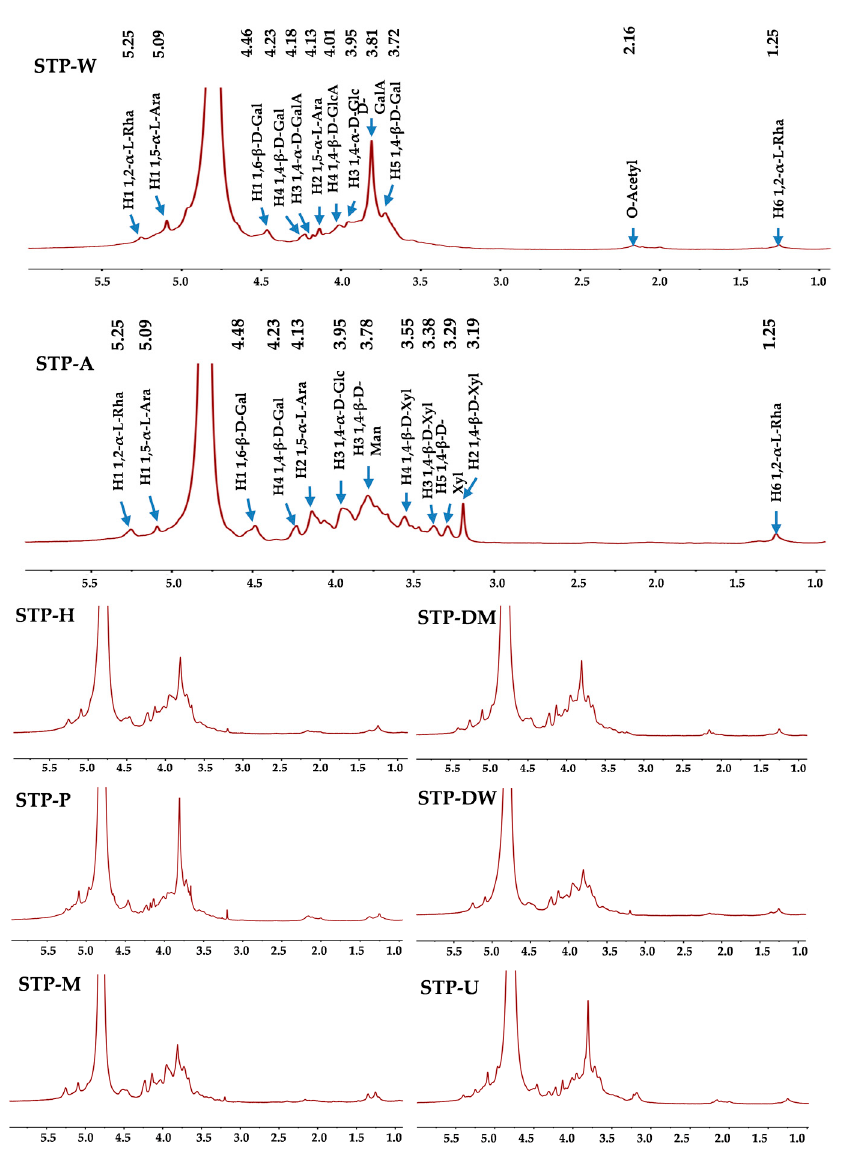
Figure 3. 1 H nmR spectra of STPs. STP-W, STP-M, STP-U, STP-P, STP-H, STP-DW, STP-DM, and STP-A indicate sweet tea polysaccharides extracted by hot water extraction, microwave-assisted extraction, ultrasound-microwave-assisted extraction, pressurized water extraction, high-speed shearing homogenization extraction, deep eutectic solvent-assisted extraction, deep eutectic solvent- microwave-assisted extraction, and alkali-assisted extraction,